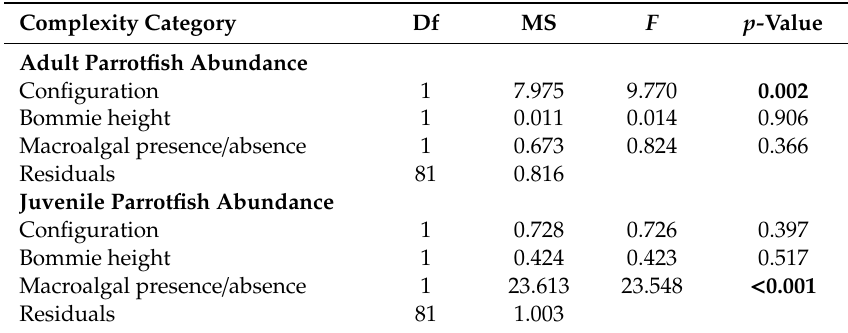
Table 2. Summary statistics of ANOVA models of the e ff ects of seascape configurations (dense versus sparse bommies), bommie height (short or high), and presence / absence of macroalgae on the abundance of scraping / excavating parrotfish at di ff erent ontogenetic stages (adults or juveniles). Numbers in bold indicate significant p -values ( p < 0.05).